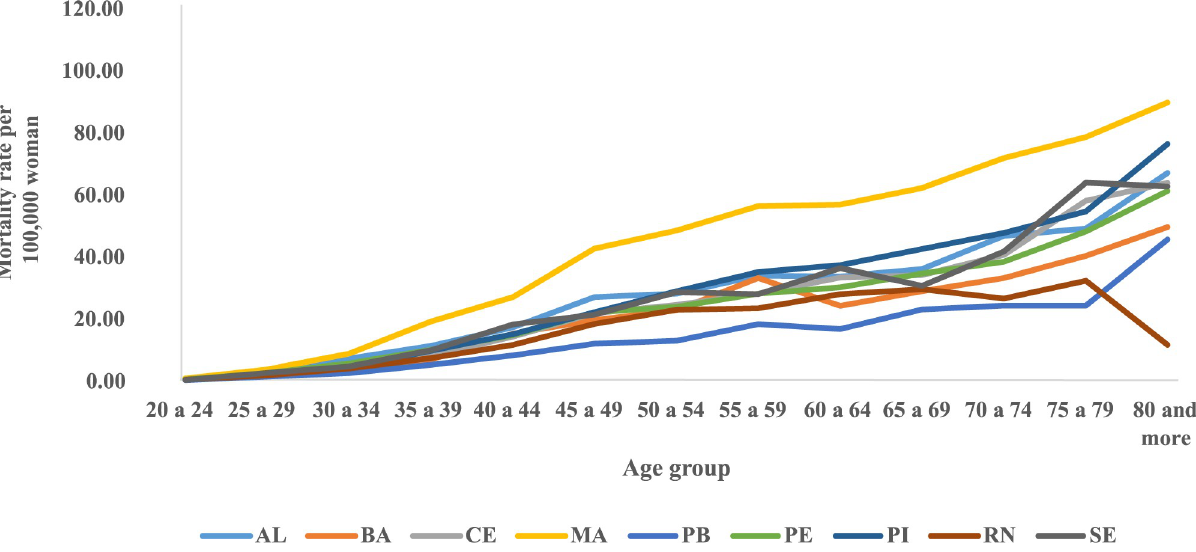
Fig 2. Distribution of mean mortality rates observed for cervical cancer according to age groups in Northeast States, Brazil, 1980–2014.